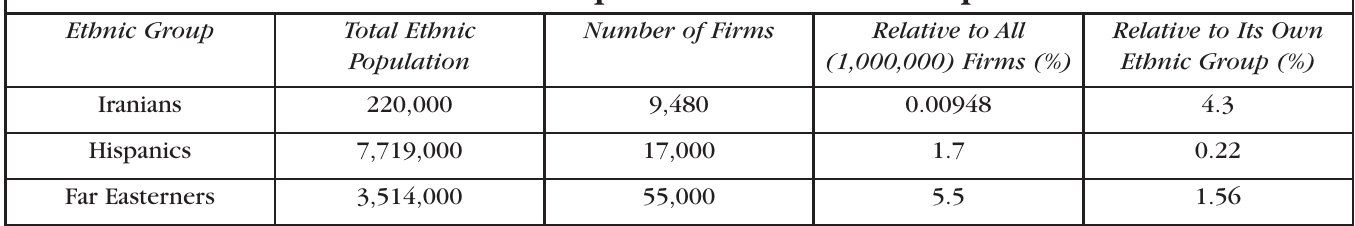
Table 11. Economic Importance of Iranian Entrepreneurs Ethnic